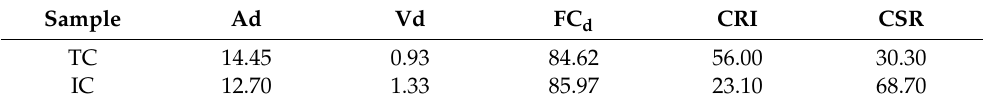
Table 1. Basic properties of TC and IC (%).